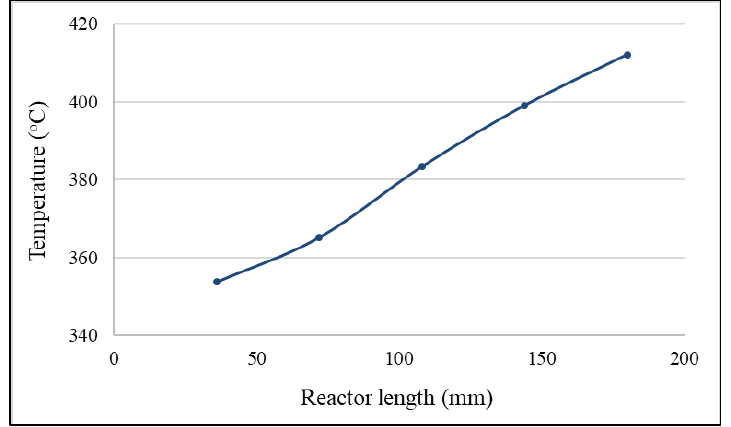
Figure 5. Temperature variations along the reactor length. Reaction conditions: Pressure, 300 psig; gas phase, hydrogen; liquid phase, 4-propylguaiacol; liquid flow rate, 0.03 mL ∙ min −1 ; gas flow rate, 0.09 mL ∙ min −1 .